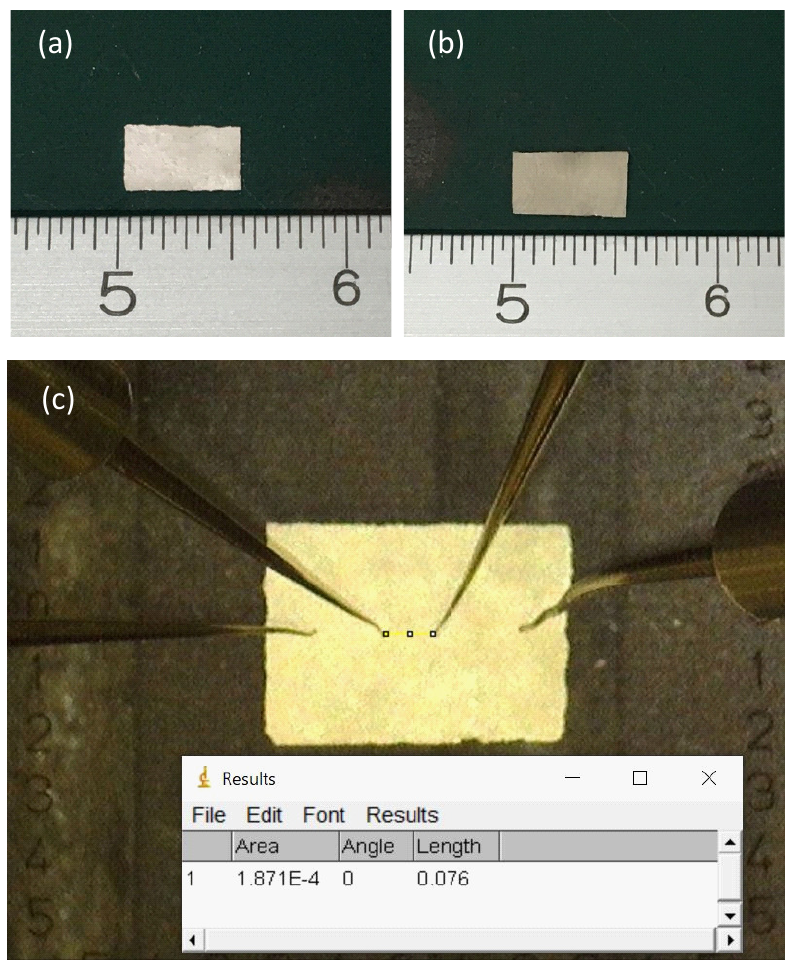
Figure 7. ( a ) Photograph of the compressed test piece; Ag toner particle. ( b ) Photograph of the compressed test piece; Ag–Ni toner particle. The electrical resistances were recorded using the 4-probe measurement, as shown in ( c